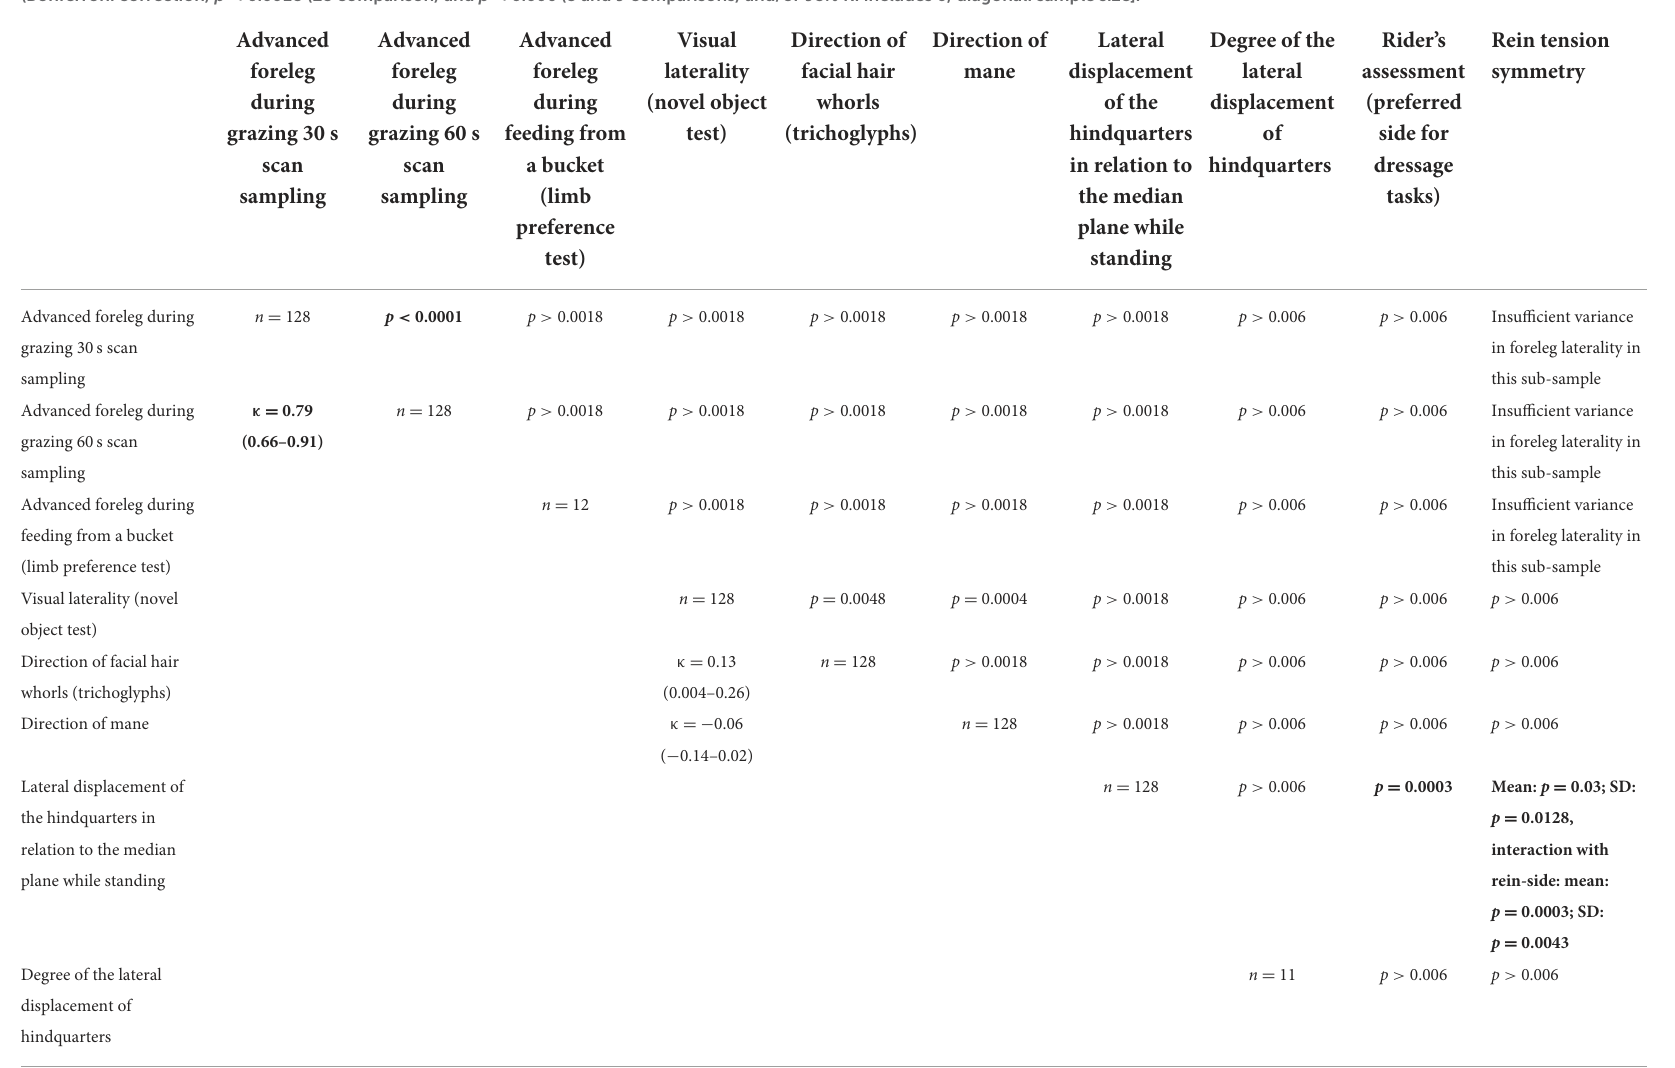
TABLE 2 Overview of the agreement between results of the applied laterality test methods across both sample populations [below diagonal (weighted) kappa coefficient and 95% KI; above diagonal: Probability > |Z| based on Mc Nemar’s test (dichotomous data) or Bowker’s Test of Symmetry (trichotomous data)/F-test for degree of hindquarters and mean + SD of rein tension; significance